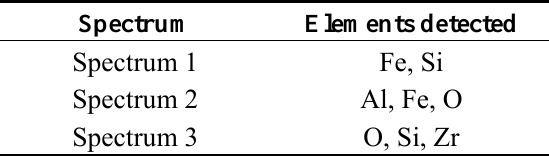
Table 3. Elements detected in Spectra 1–3 in Figure